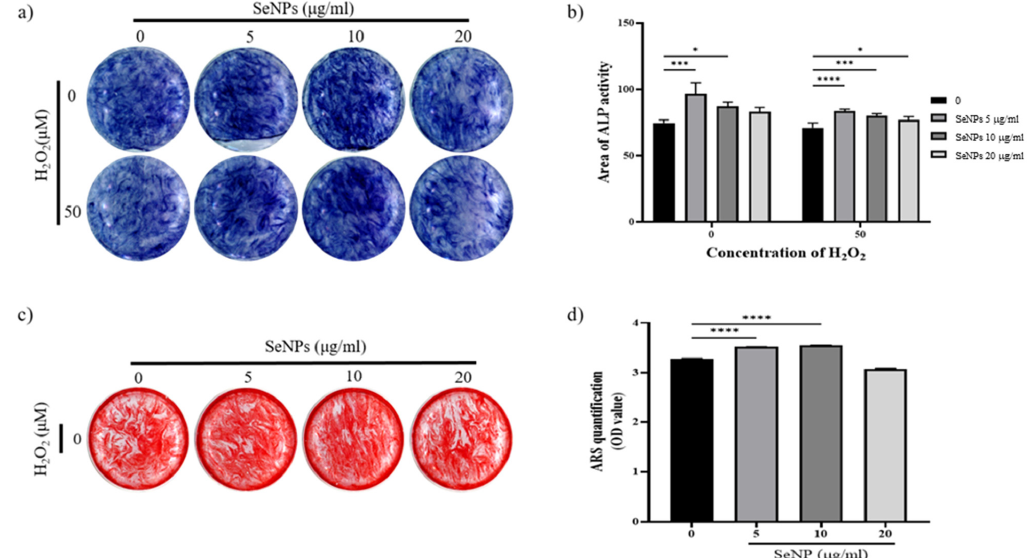
Figure 6. Effect of SeNPs on ALP activity and mineralization in MC3T3-E1 cells. ( a ) Results of ALP staining of cells on day 14 after treatment with different concentrations of SeNPs. Higher ALP activity was shown in the 5–10 μ g/mL SeNP-treated group than in the SeNP nontreated group. ( b ) ALP quantitative graph. Both H 2 O 2 -treated and untreated groups showed high ALP activity at SeNP concentrations of 5–10 μ g/mL. ( c ) The formation of calcium deposits is indicated by ARS staining. After treatment with different concentrations of SeNPs, cells were stained with ARS 28 days after treatment with osteogenic differentiation medium. Higher calcium deposition was observed in the group treated with 5 μ g/mL selenium and 10 μ g/mL selenium without H 2 O 2 . ( d ) Results of quantification of ARS staining using CPC extraction. Statistical significance was calculated using one-way ANOVA followed by a two-sided Dunnett post hoc test compared to CTL. * Represents p < 0.05, *** p < 0.001, **** p < 0.0001.